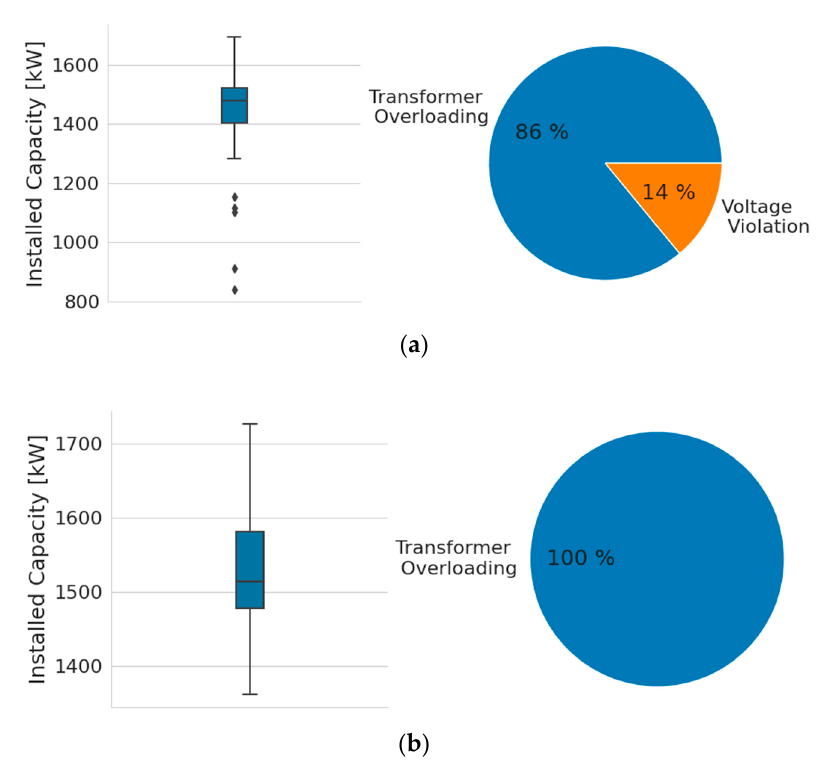
Figure 7. Results of the hosting capacity analysis for a modified IEEE 34-bus feeder for various experiments. ( a ) Non-control case; ( b ) secondary QU control.